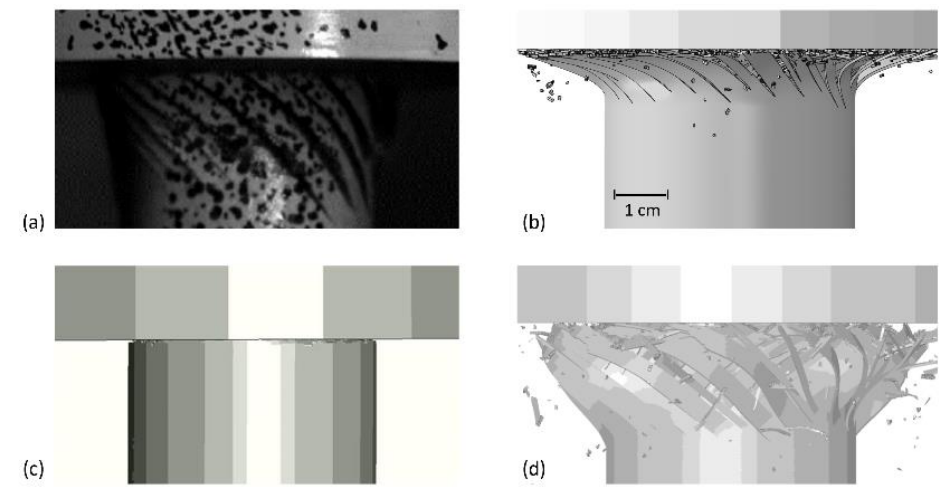
Fig. 4 . Damage morphology in a [+45 4 /-45 4 ] 2s specimen after 0.9 ms. (a) Experimental. (b)